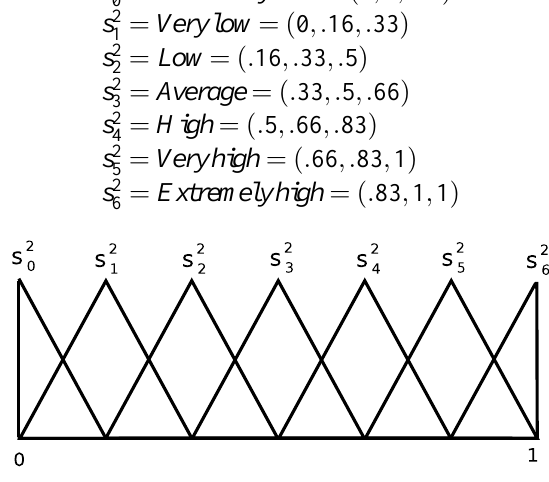
Fig. 3. The linguistic term set S